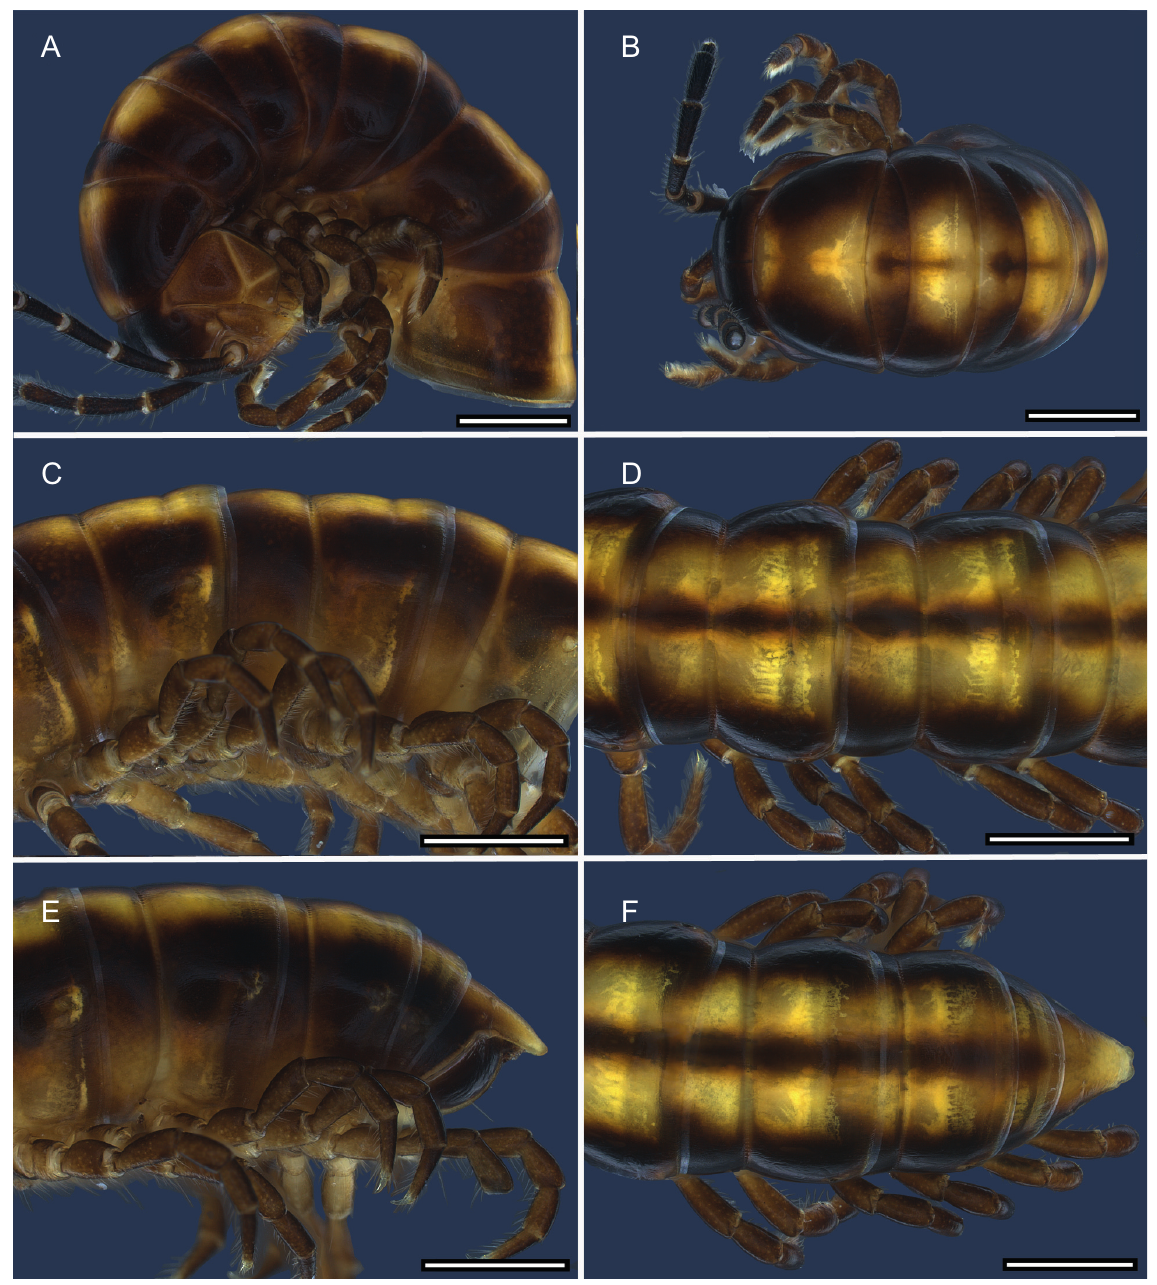
Fig. 18. Pogonosternum jeekeli Decker, sp. nov., ♂, holotype from Warby-Ovens National Park, Devenish-Wangaratta Road (NMV K-12178). A – B . Anterior rings. A . left lateral view. B . Dorsal view. C – D . Rings 10 and 11. C . Left lateral view. D . Dorsal view. E – F . Posterior rings. E . Left lateral view, F . Dorsal view. Scale bars: 1